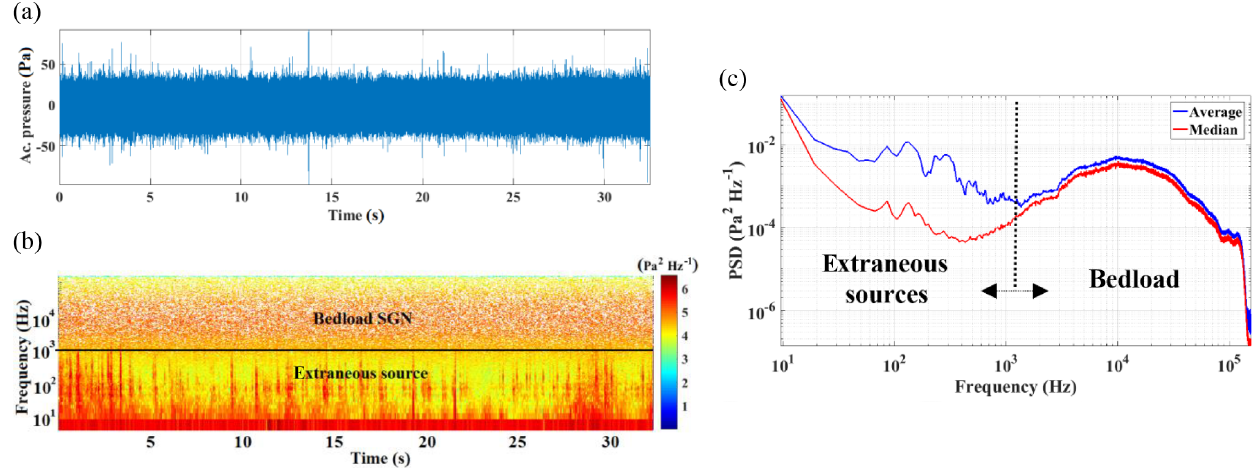
Figure 7. Signal representations of the SGN recorded during hydrophone experiments on the Isère River (France): (a) temporal signal in units of Pa; (b) time–frequency representation (spectrogram), with the color code normalized with respect to power values, in Pa 2 Hz − 1 ; the specific frequency bandwidth of the bedload acoustic effects and of the hydrodynamic noise agitation (extraneous sources) are indicated; (c) the PSD curve, also in Pa 2 Hz − 1 , estimated using either the average or the median power values, in time, from the spectrogram in (b)